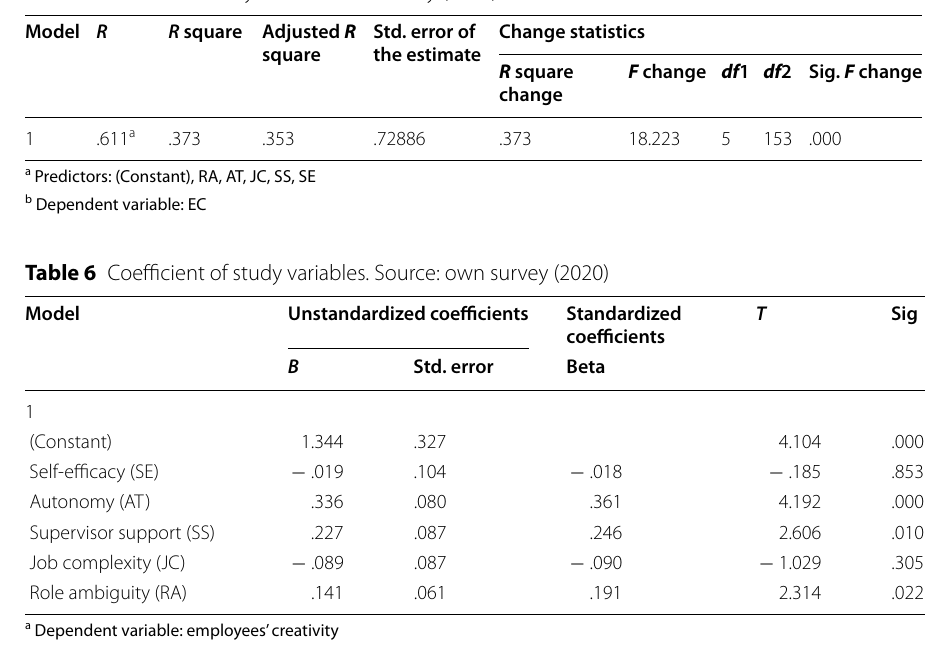
a Dependent variable: employees’